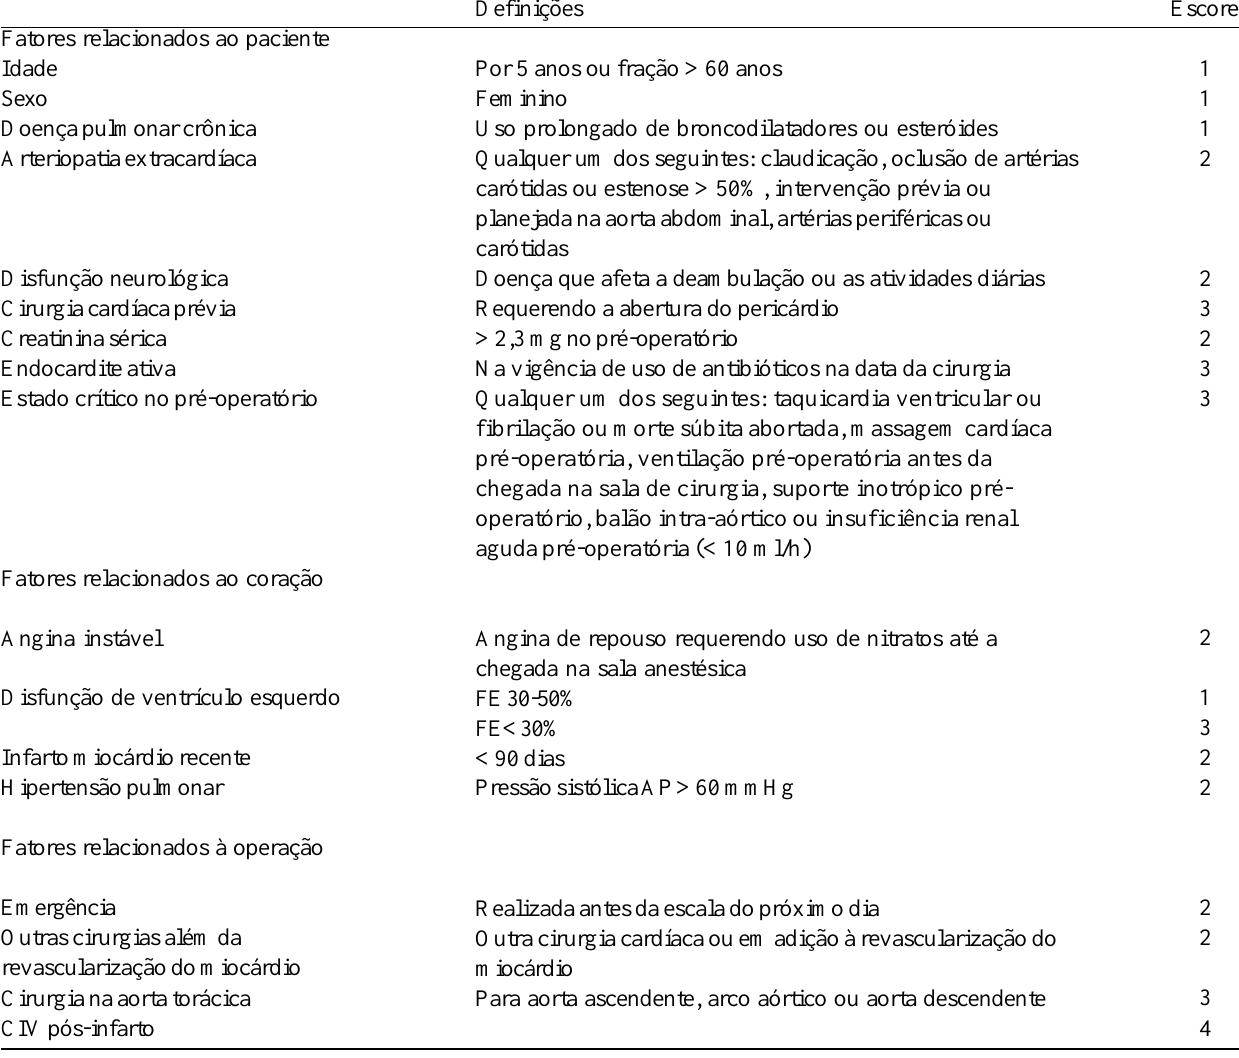
Tabela 1. Fatores de riscos, definições e